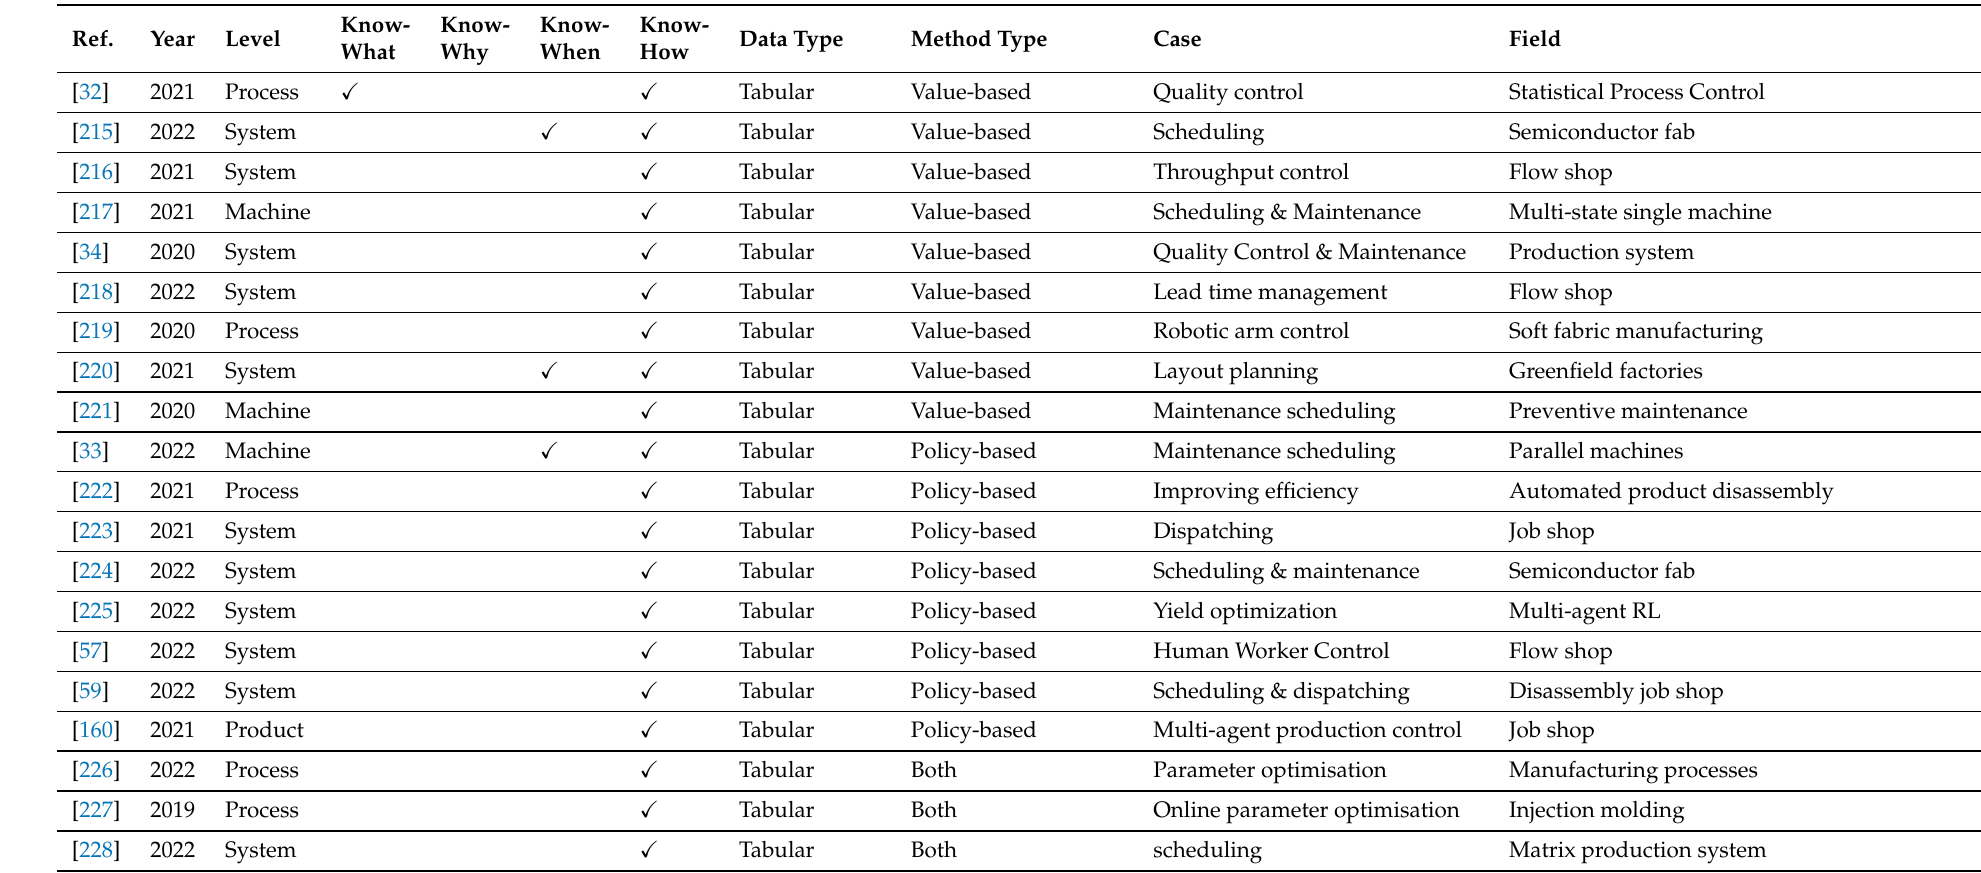
Table A4. Categories of reinforcement learning